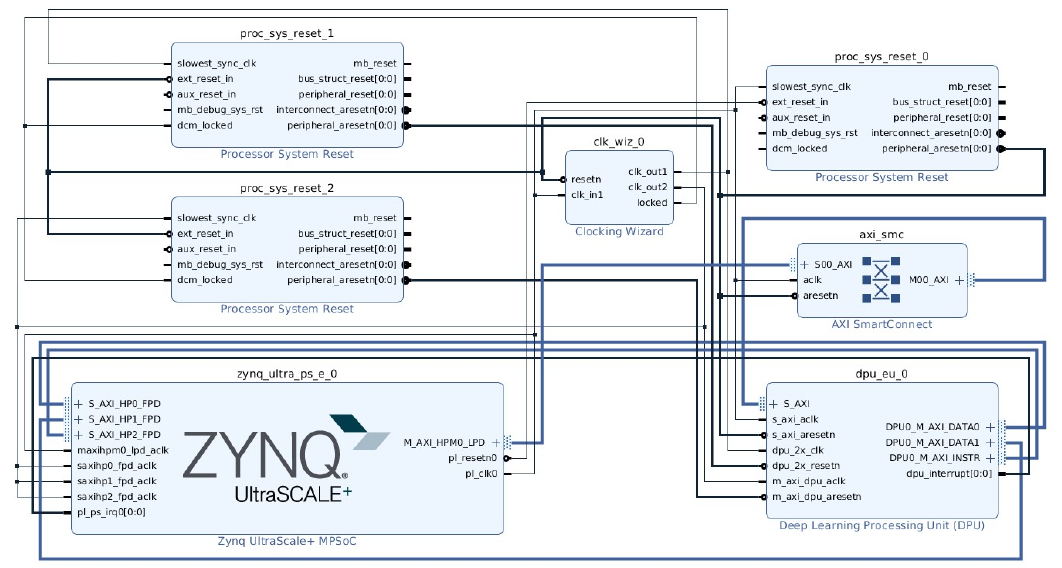
Figure 14. Hardware Block Design in